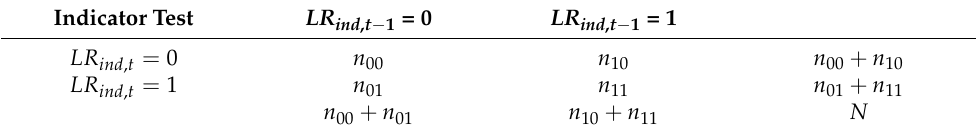
where LR ind , t = a test indicator on day t